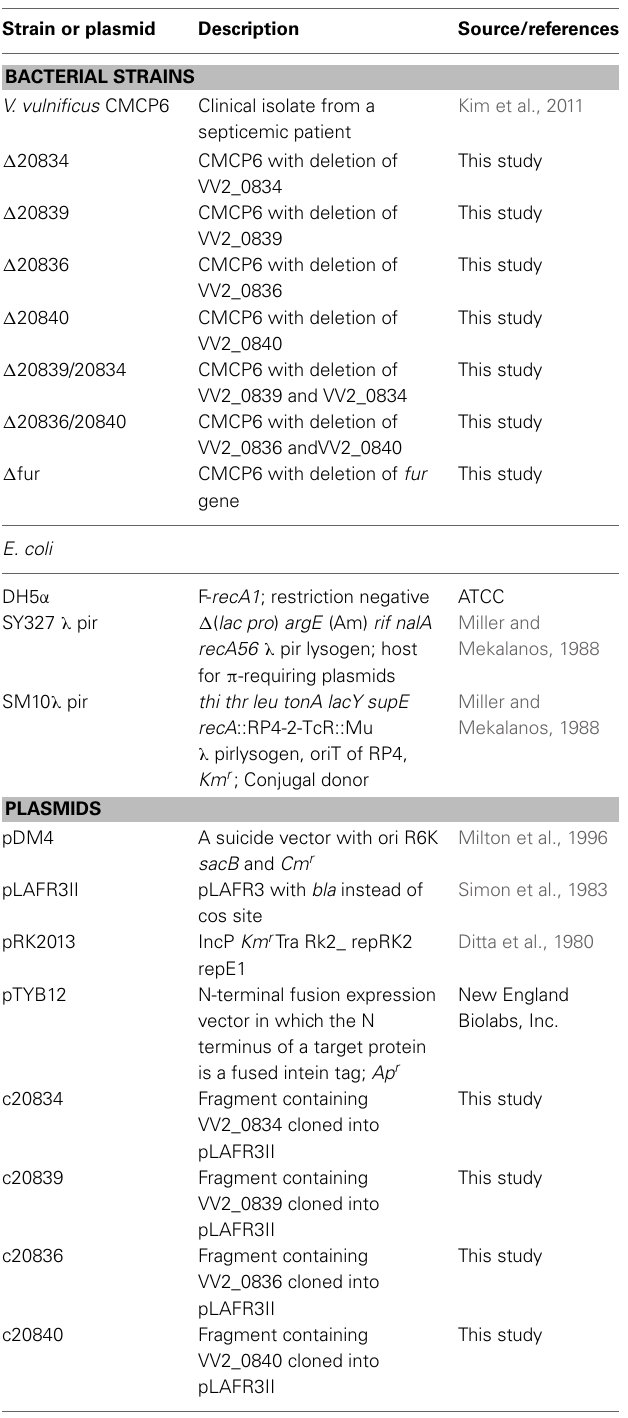
Table 1 | Strains and plasmids used in this study. Table 2 | Primers used in the present